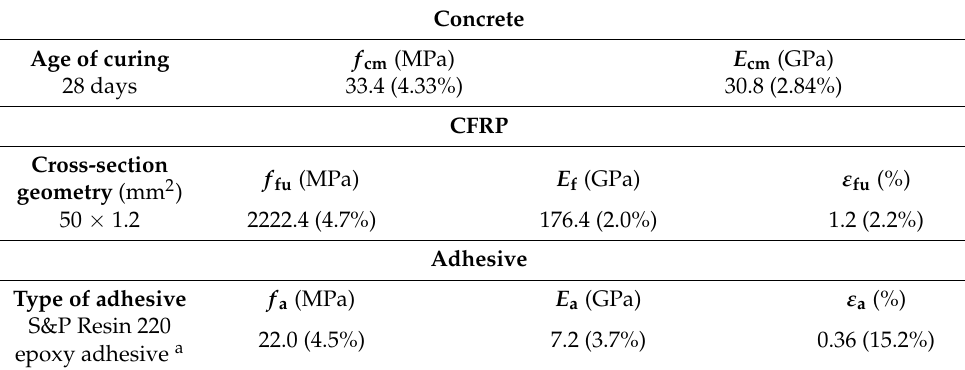
Table 3. Material characterization (average values).